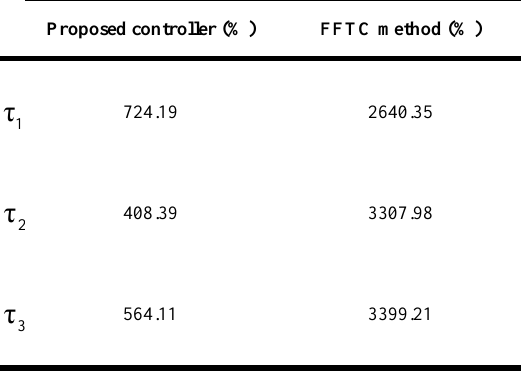
Table 2. Comparison of Total Harmonic Distortion (THD) between the proposed and FFTC